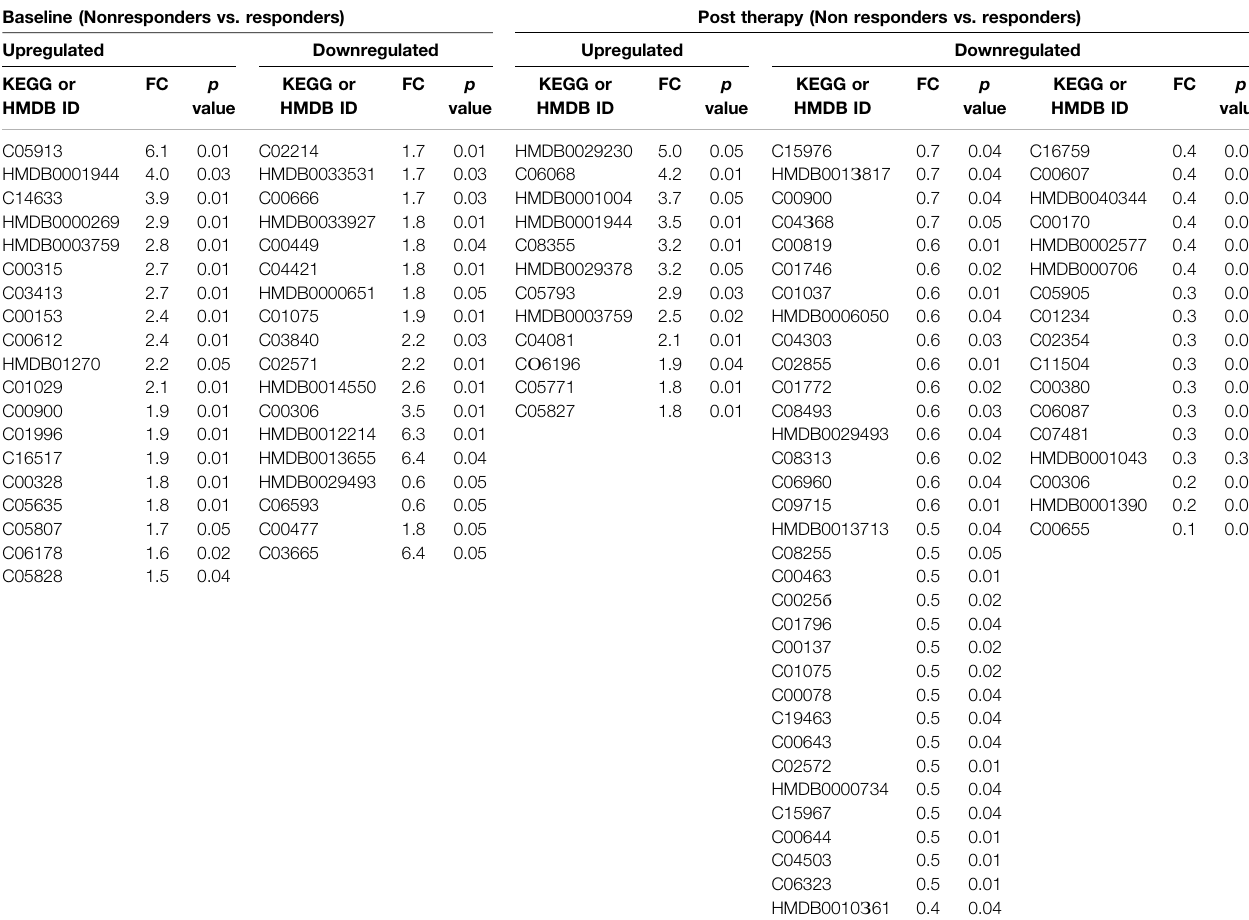
TABLE 1 | Differentially expressed metabolites in DAA Nonresponders compared to responders at baseline and at post therapy [signi fi cance ( p < 0.05)]. Baseline (Nonresponders vs.